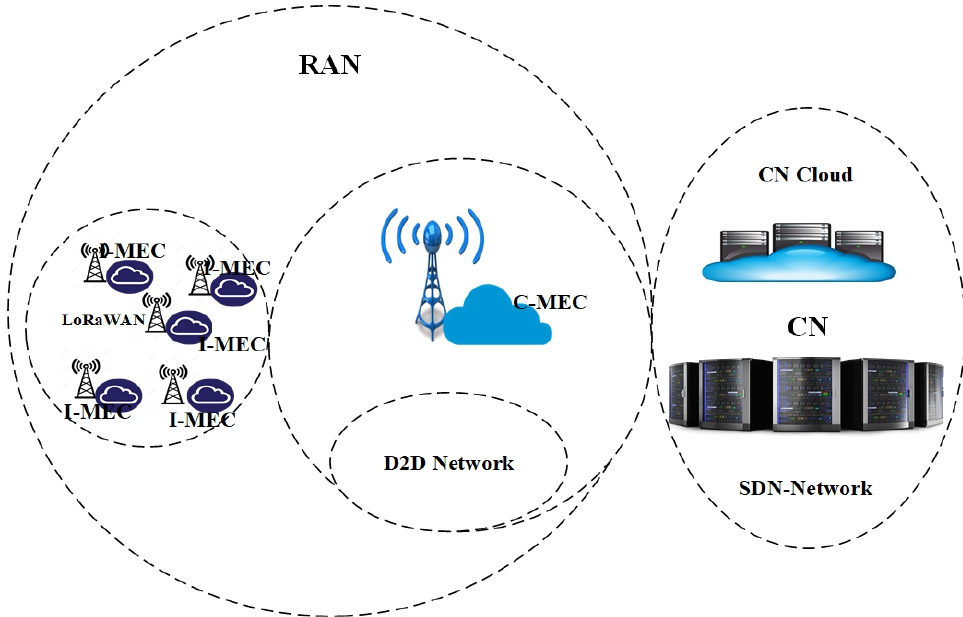
Figure 7. Topology of the simulated network. Table 4. Simulation parameters of the radio access network (RAN) of a cellular network. Table 3. Simulation parameters of LoRaWAN